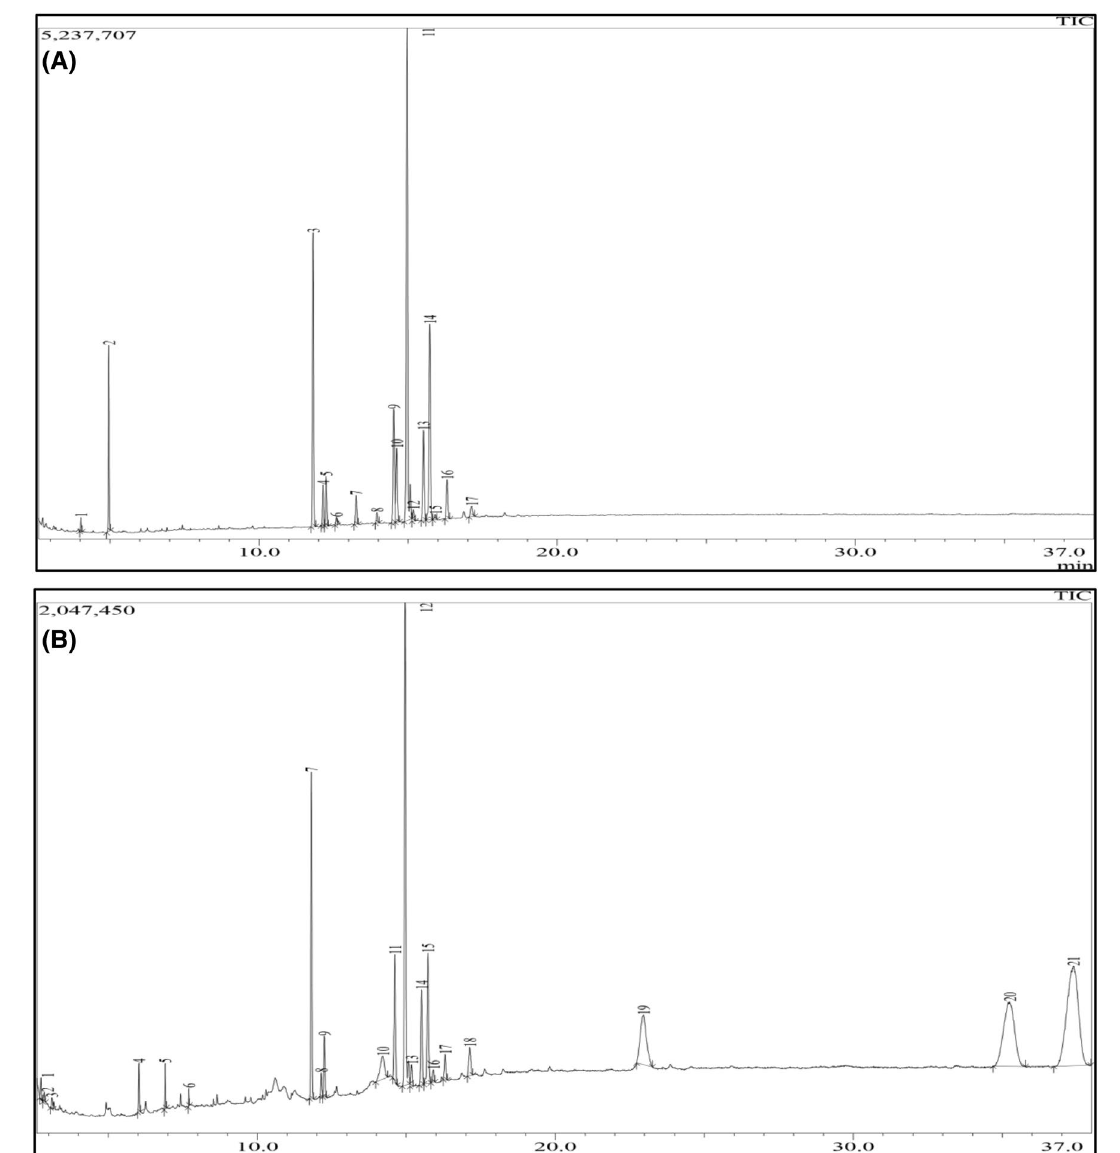
Fig. 2 Representative GC/MS chromatograms of the acid compounds of FOMW ( a ) and DOMW ( b ). The order and identification pic was detailed in Table